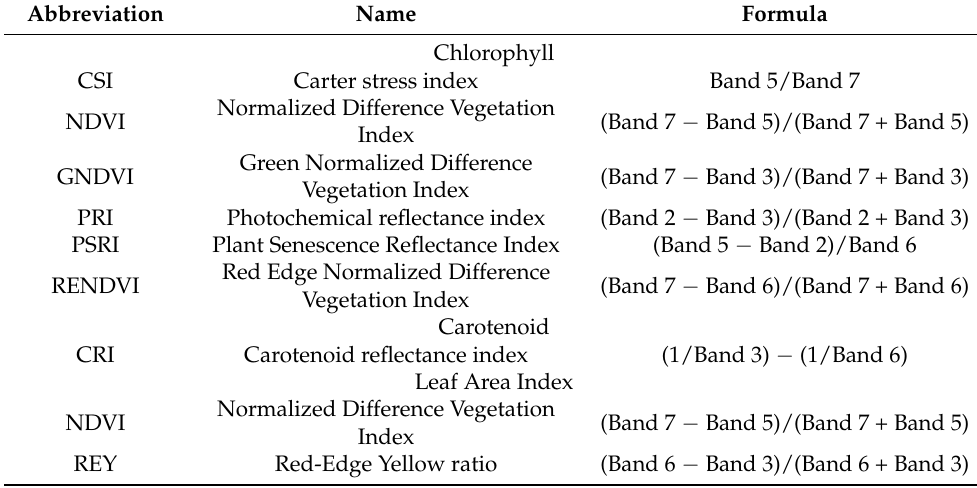
Table 2. World View-2 vegetation indices (VIs) were used as predictor variables for building regres- sion and classification models of defoliation, LAI, and pigments content